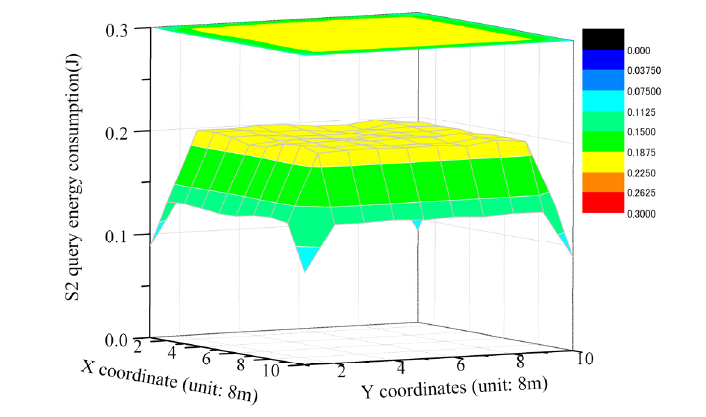
Figure 9. Energy consumption distribution among